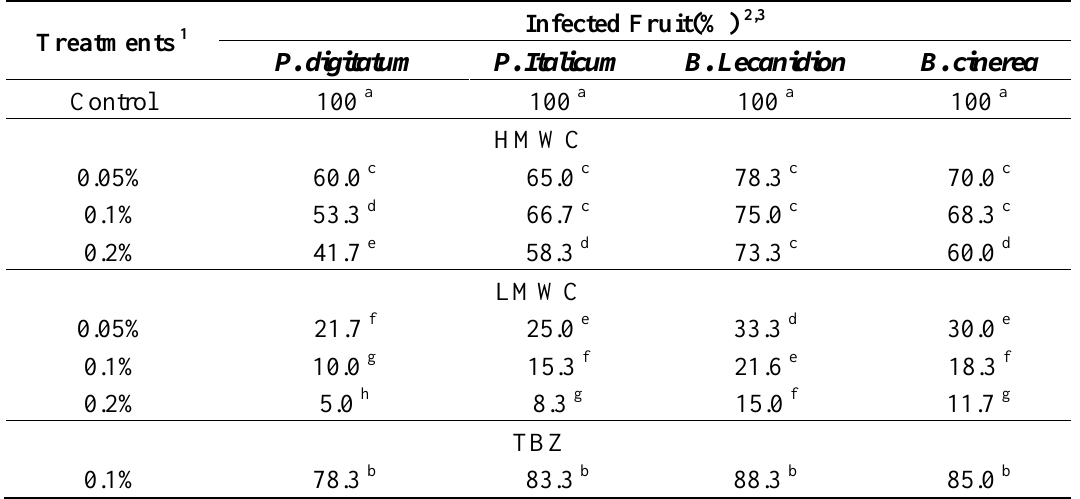
Table 1. Effect of low molecular weight chitosan (LMWC) on decay of citrus fruits caused by Penicillium digitatum , Penicillium italicum , Botrydiplodia lecanidion and Botrytis cinerea . Reproduced from Reference [15].